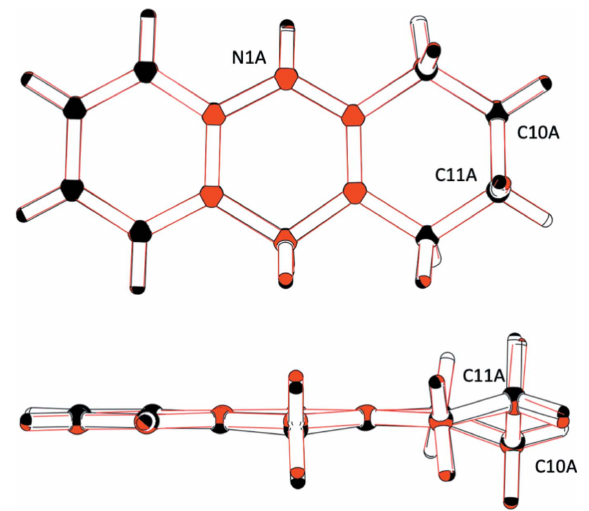
Figure 2 Overlay (Spek, 2020) of the independent cations in the title compound in the least-squares (top) and most-squares plane (bottom); residue A is depicted in black, residue B in red.